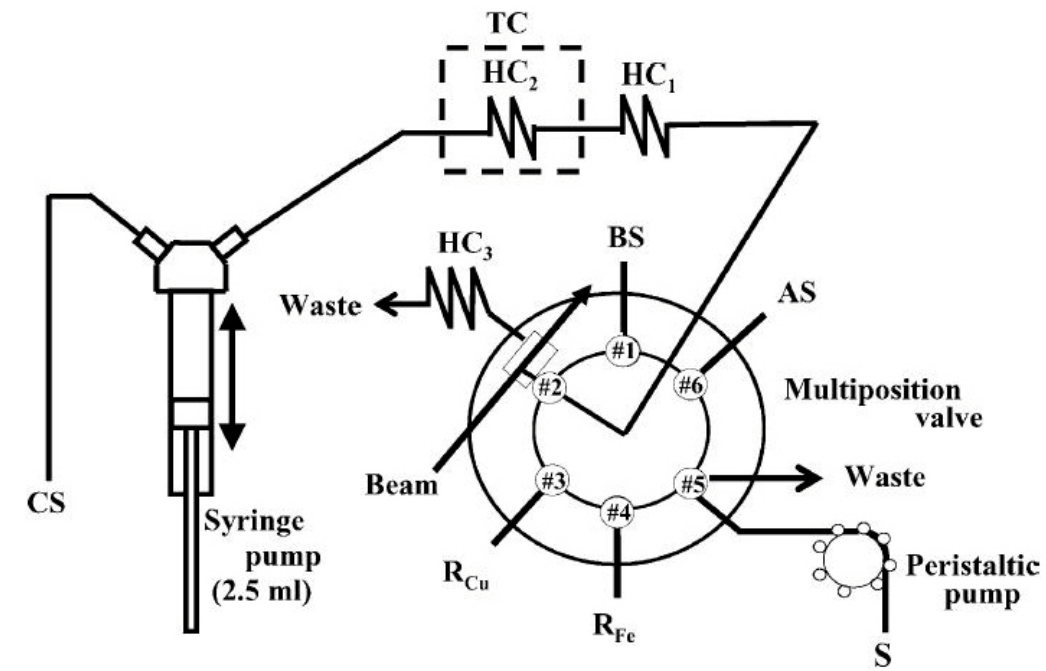
Figure 4 Manifold of the SIA system in the proposed method. HC , holding coil2 (0.5mm i.d., 55 cm); HC HC 2 controller (45 .C); CS, 5×10 -5 mol l -1 5-Br-PSAA in 0.01 mol l -1 HCl; R R , 7×10-4 mol l -1 5-Br-PSAA; S, sample containing copper and/or iron; AS, 5×10-4 mol l -1 Fe